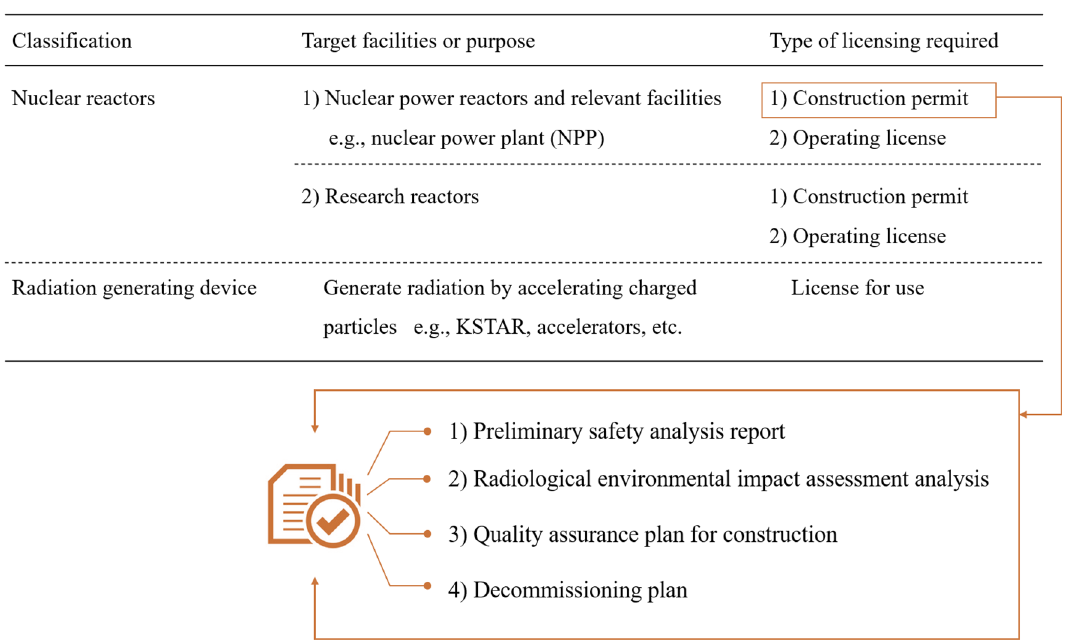
Figure 2. Categories of nuclear facilities and corresponding license requirements prescribed by the Nuclear Safety Act of